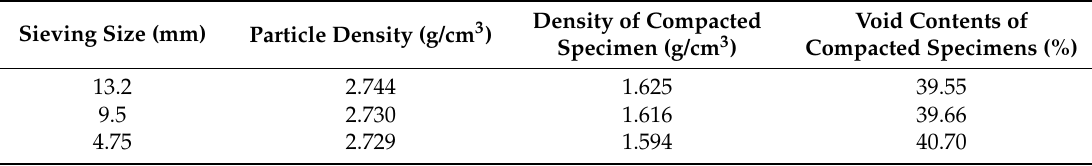
Table 5. Materials for laboratory penetration